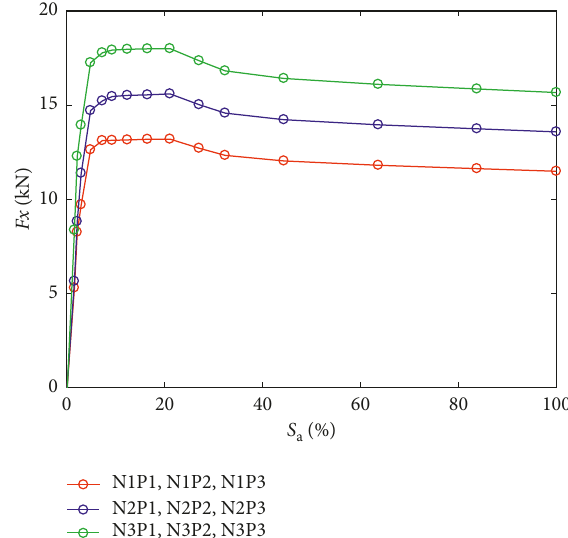
Figure 7: Ground reaction force at different angular velocities during the tire rolling phase.